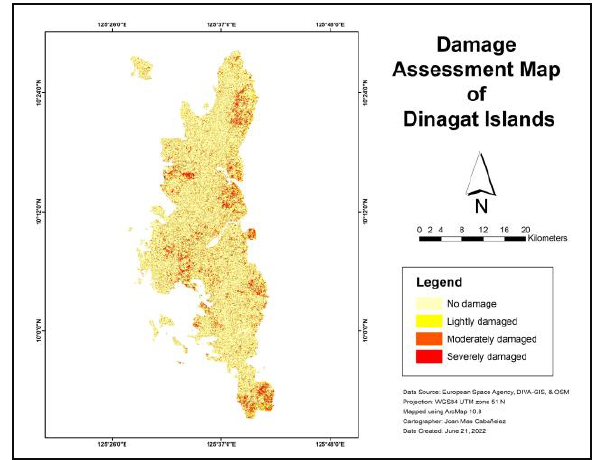
Figure 19 . Coherence-based derived damage assessment map for Dinagat Islands using Sentinel-1 SAR image